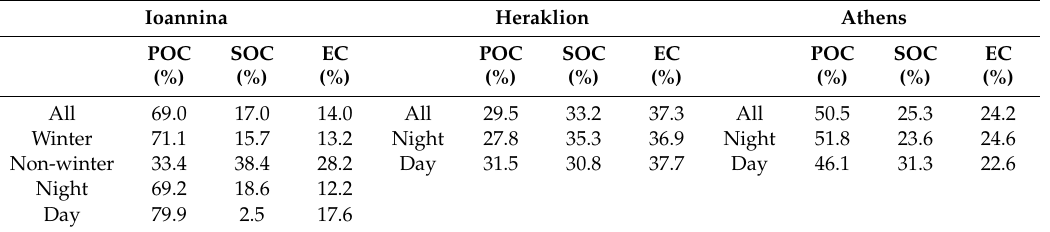
Table 2. Percentage contribution of POC, SOC (estimated via MRS), and EC to the total carbon (TC) mass (TC = OC + EC) in Ioannina, Heraklion, and Athens for various sampling periods. Ioannina Heraklion